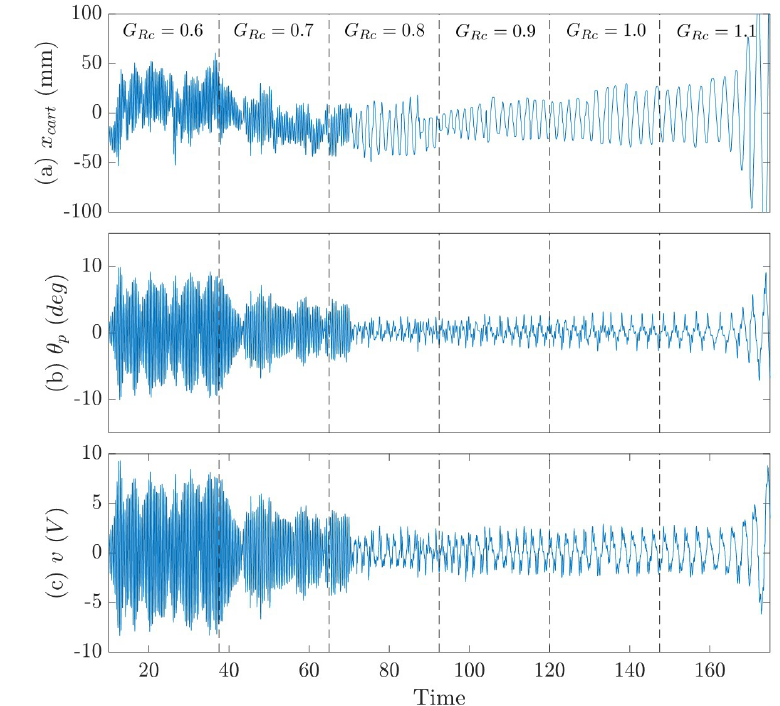
Figure 8. The experimental result for inner-loop LQR c